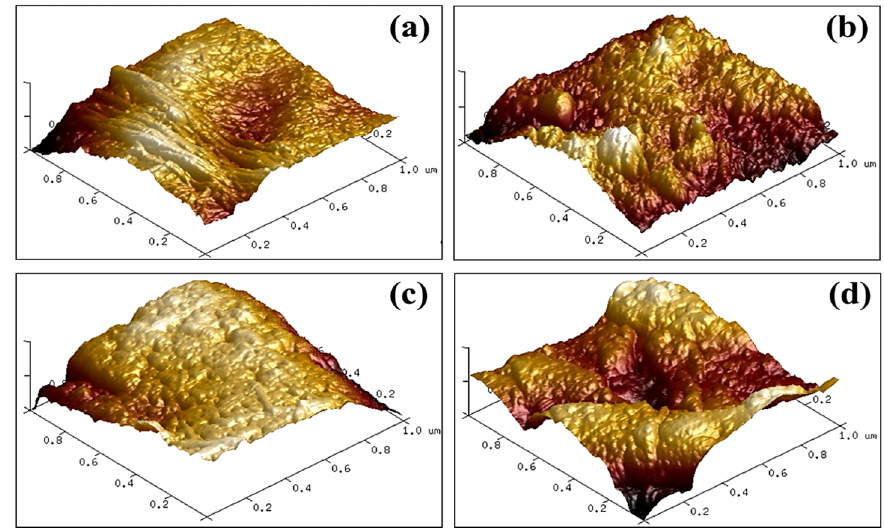
Figure 5. 3D AFM morphology images of rice straw. ( a ) Untreated, ( b ) laccase only, ( c ) laccase + [AMIM]Cl, ( d ) laccase + TritonX-100. Table 3. AFM surface roughness factor of untreated and pretreated rice straw.